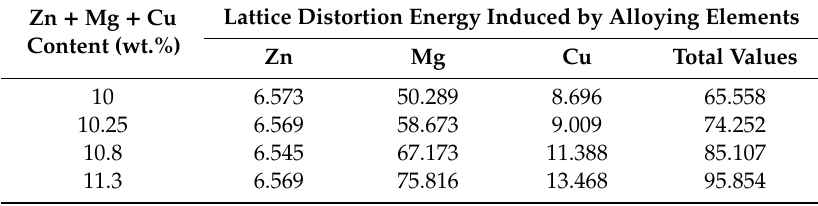
Table 4. Variation of lattice distortion energy in solid solution.